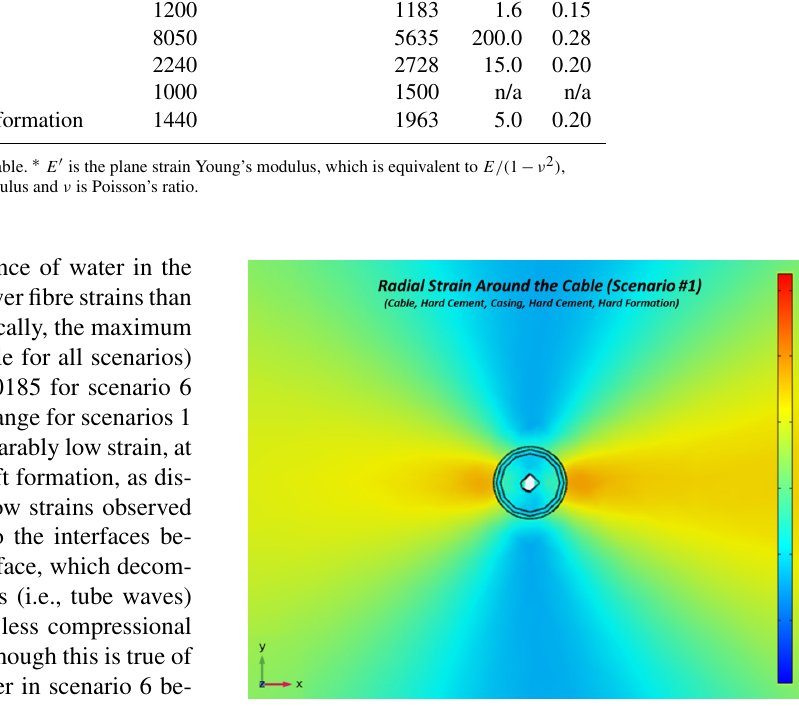
Figure 5. Radial strain around the cable as a response of compres- sional wave propagation at a 90 ◦ incident angle in scenario 1 (inci- dent waveform is incoming from the right).